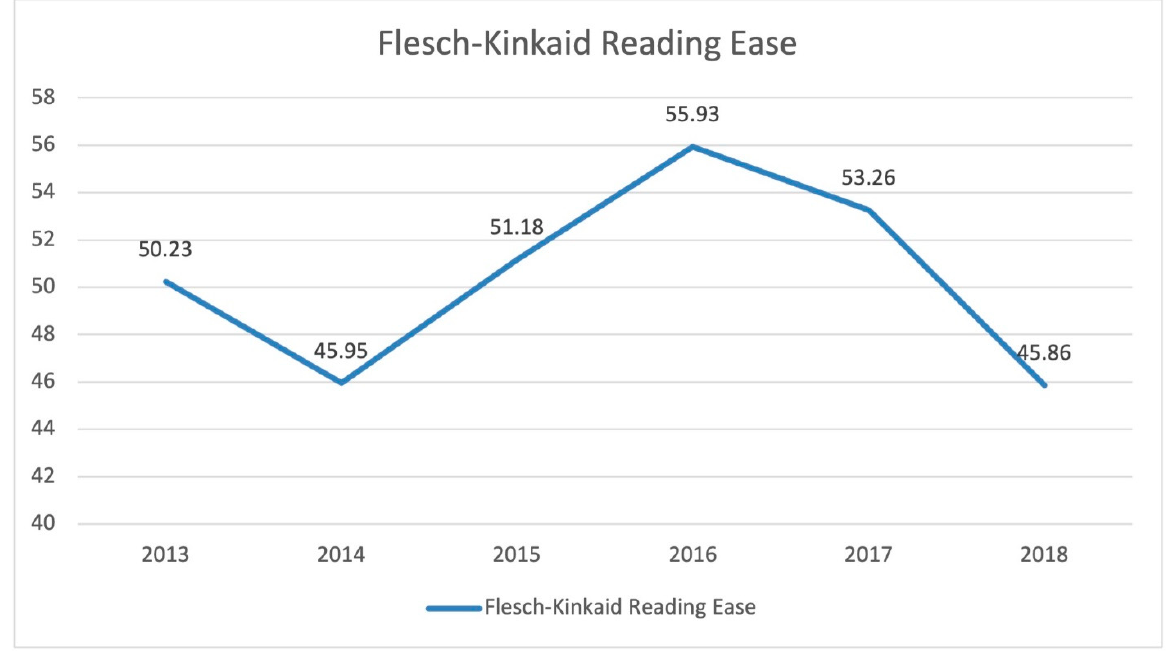
Figure 1. Trends of FKRE scores